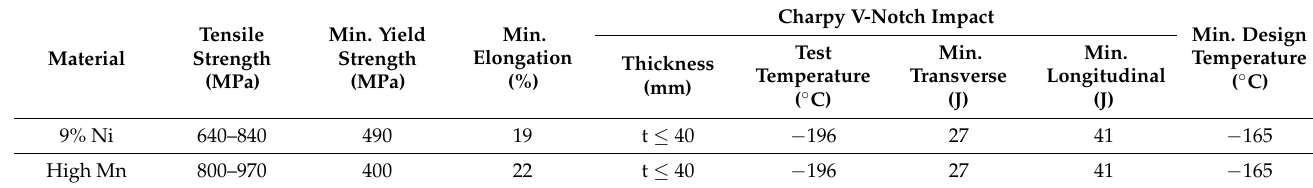
Table 2. Mechanical properties for low-temperature service [18,19].